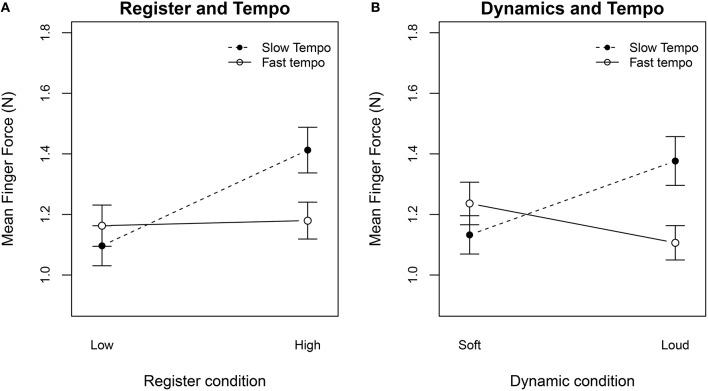
Finger forces measured (Fmean) for the high expression level performances of the Weber Concerto excerpts. Graph shows the interactions of the register, the dynamics and the tempo. (A) For slow tempi, participants' finger forces increased when playing in the high register, whereas for the fast tempi conditions the finger forces remained constant (solid line). (B) Louder dynamics resulted in increased finger forces for the slow tempo condition but showed an opposite effect for the fast tempo. The error bars show the standard error of the mean.